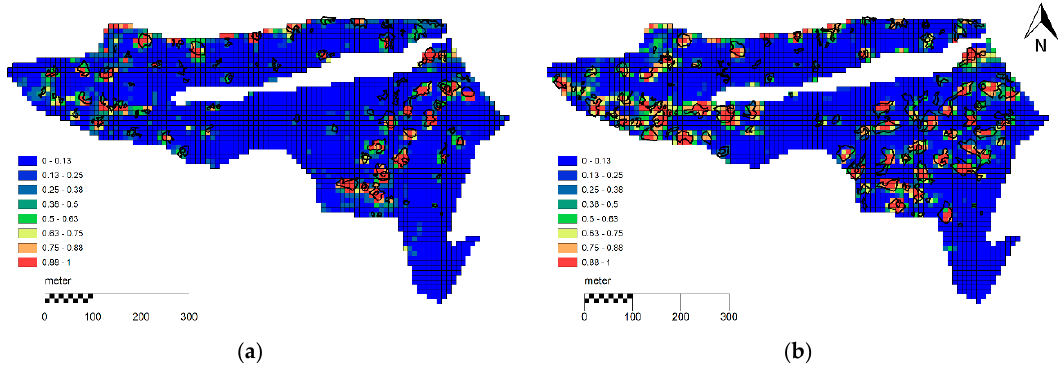
Figure 12. Treefall gap fuzziness map evaluated from time series for 2015 ( a ) and 2016 ( b ) at the OS1 on a 10 m resolution grid. Reference treefall gap polygons shown with black outline for both years. Table 11. Evaluated area from time series on OS1.